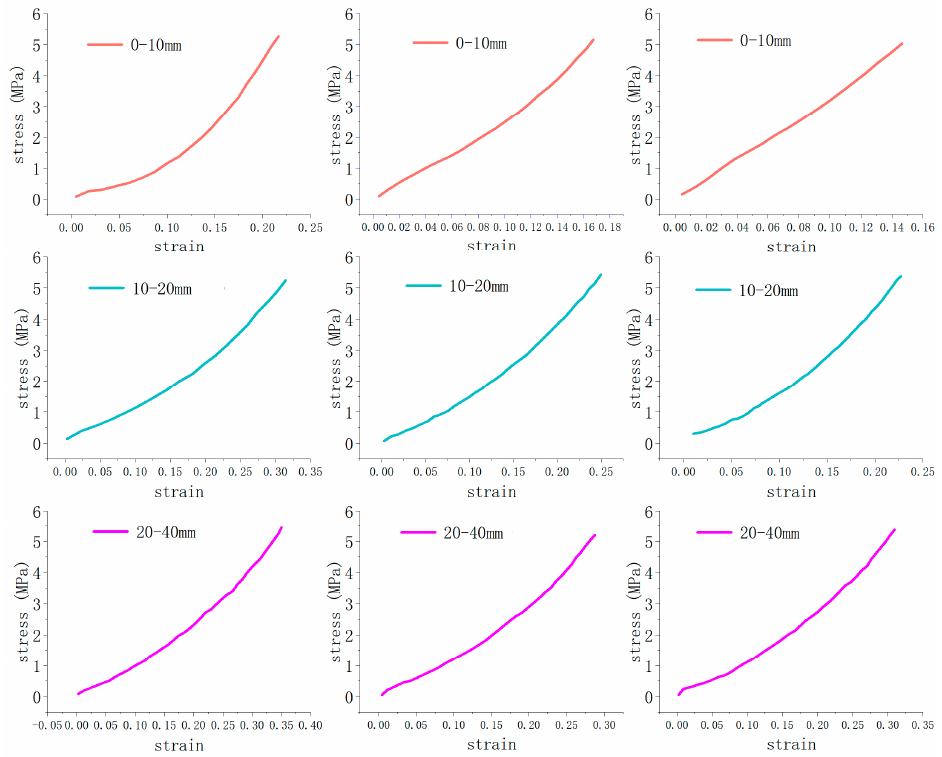
Figure 8. Stress-strain curves of flexible material backfilling body.